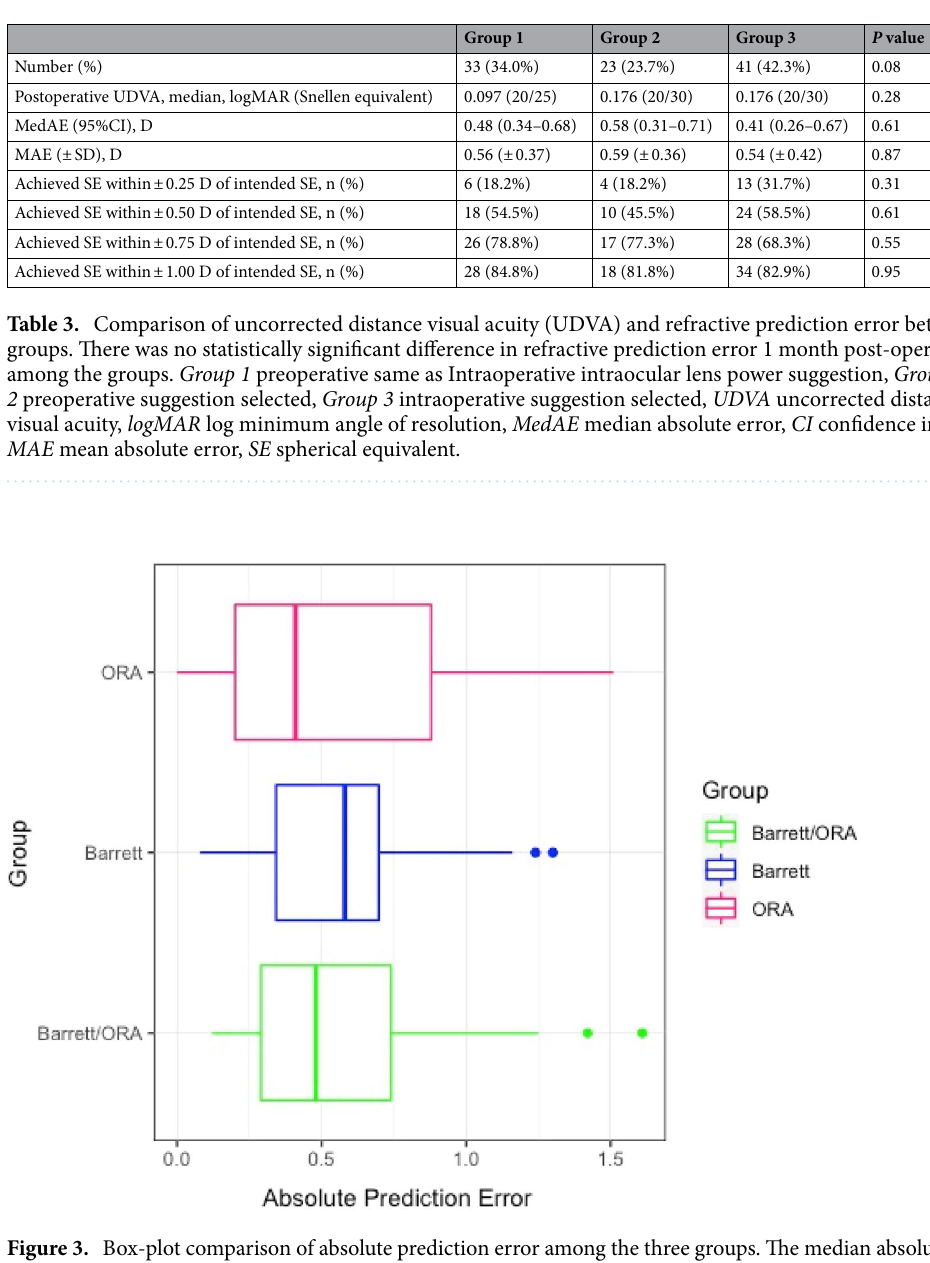
Figure 3. Box-plot comparison of absolute prediction error among the three groups. The median absolute error for group 3 (ORA) was lower than the other groups, although not statistically significant ( P = 0.54). Note : Group 1 (Barrett/ORA): preoperative and intraoperative methods predicted same IOL power. Group 2 (Barrett): preoperative method suggestion was selected over intraoperative method. Group 3 (ORA): intraoperative method suggestion was selected over preoperative method.